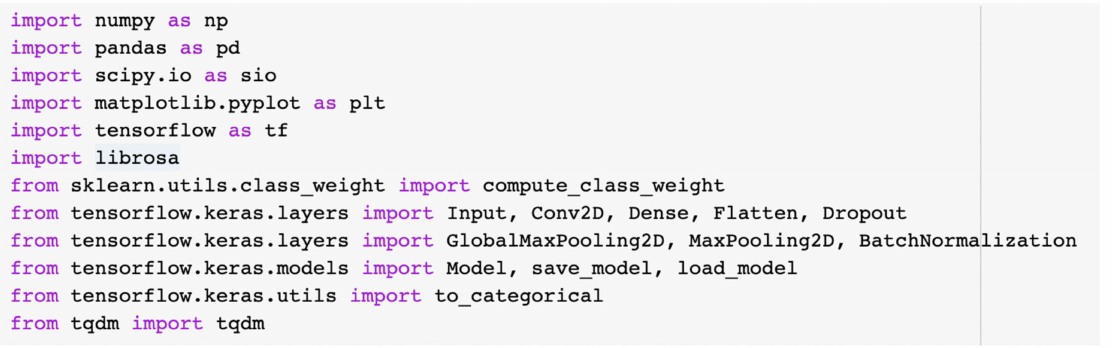
Figure A1. Dependencies and Libraries used in this experiment.